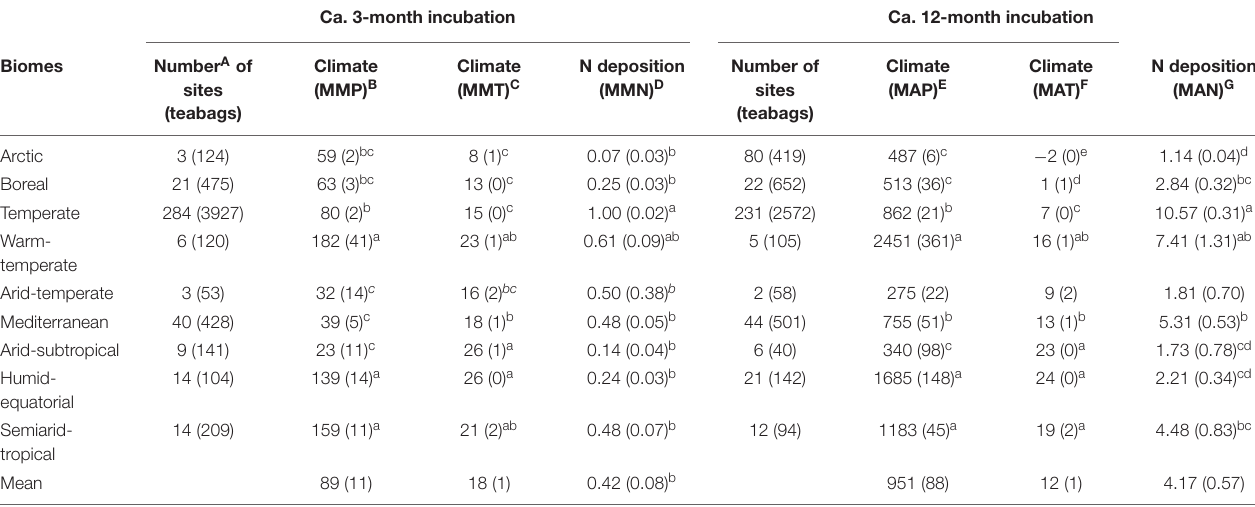
TABLE 1 | Summarized characteristics of the study sites used for the analyses within the TeaComposition